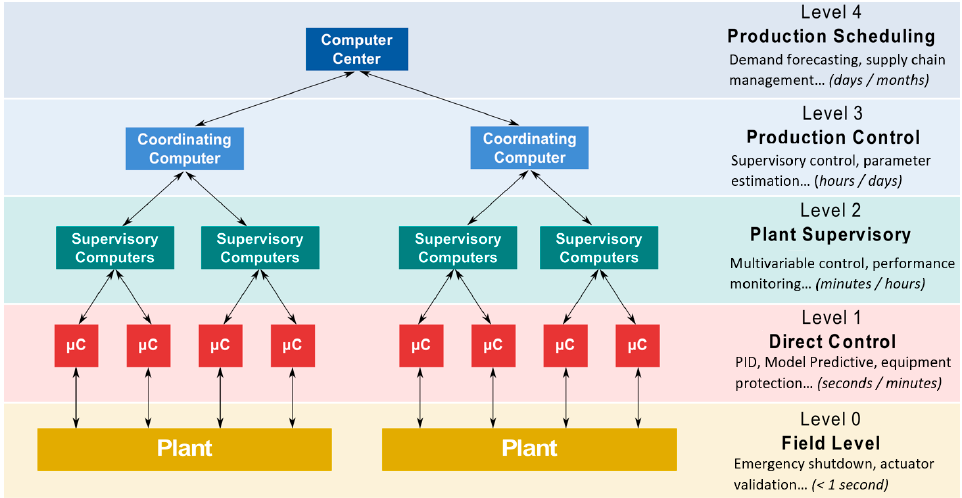
Figure 5. Functional levels of control systems. Source: Adapted from the work of Daniele Pugliesi [201]. License CC BY-SA 3.0.